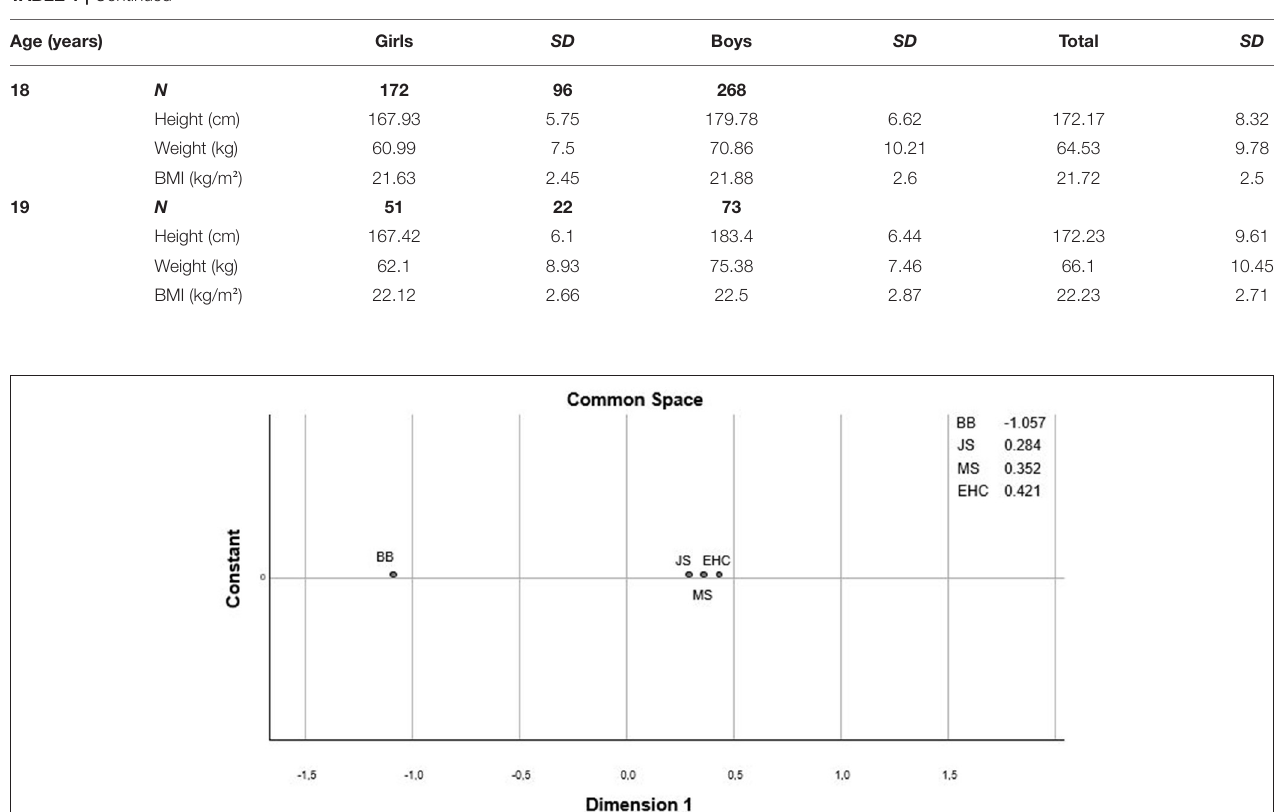
FIGURE 1 | One-dimensional configuration for the four items of the KTK3 + test battery. Dimension 1 represents the geometrical distance between the test items (JS, jumping sideways; MS, moving sideways; BB, balancing backwards; EHC, eye-hand coordination) translated as the (dis)similarities between the items, with small distances indicating a high correlation or small dissimilarity and large distances indicating a low correlation or large